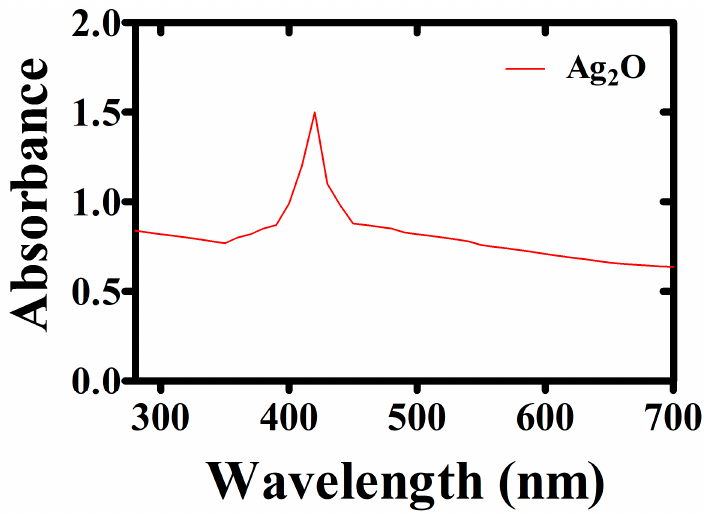
Figure 2. Biologically produced calcinated Ag 2 ONPs UV-visible spectrum .